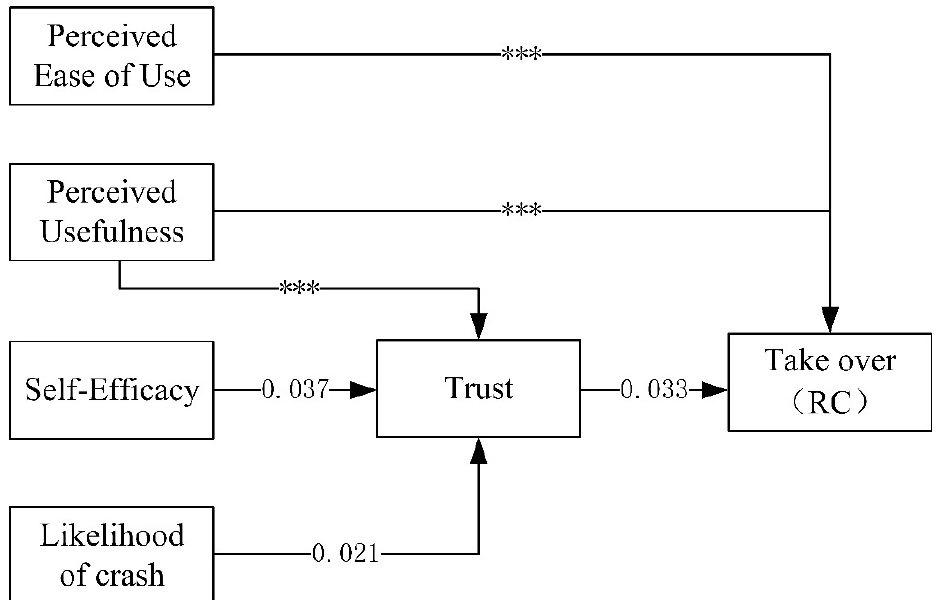
Figure 3. Value of RC model Notes: *** p < 0.001.